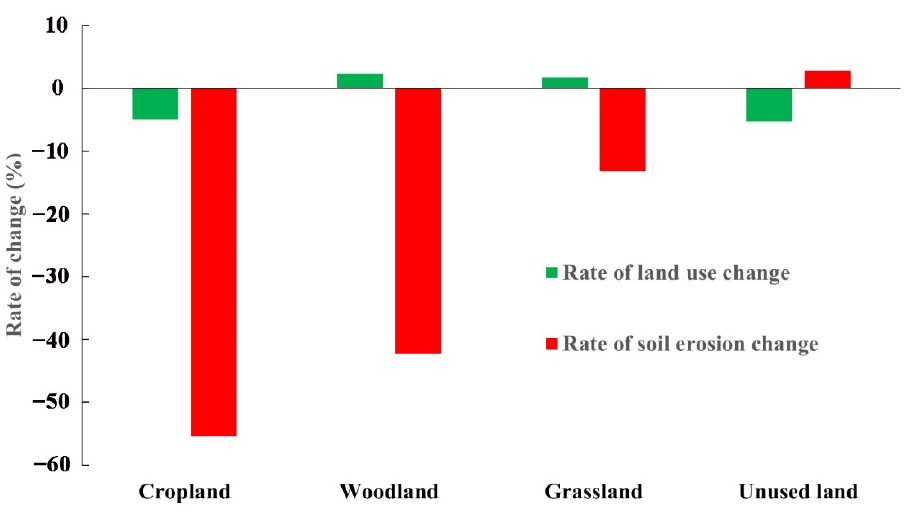
Figure 6. Links between SE and land-usage alteration from 2000 to 2020.